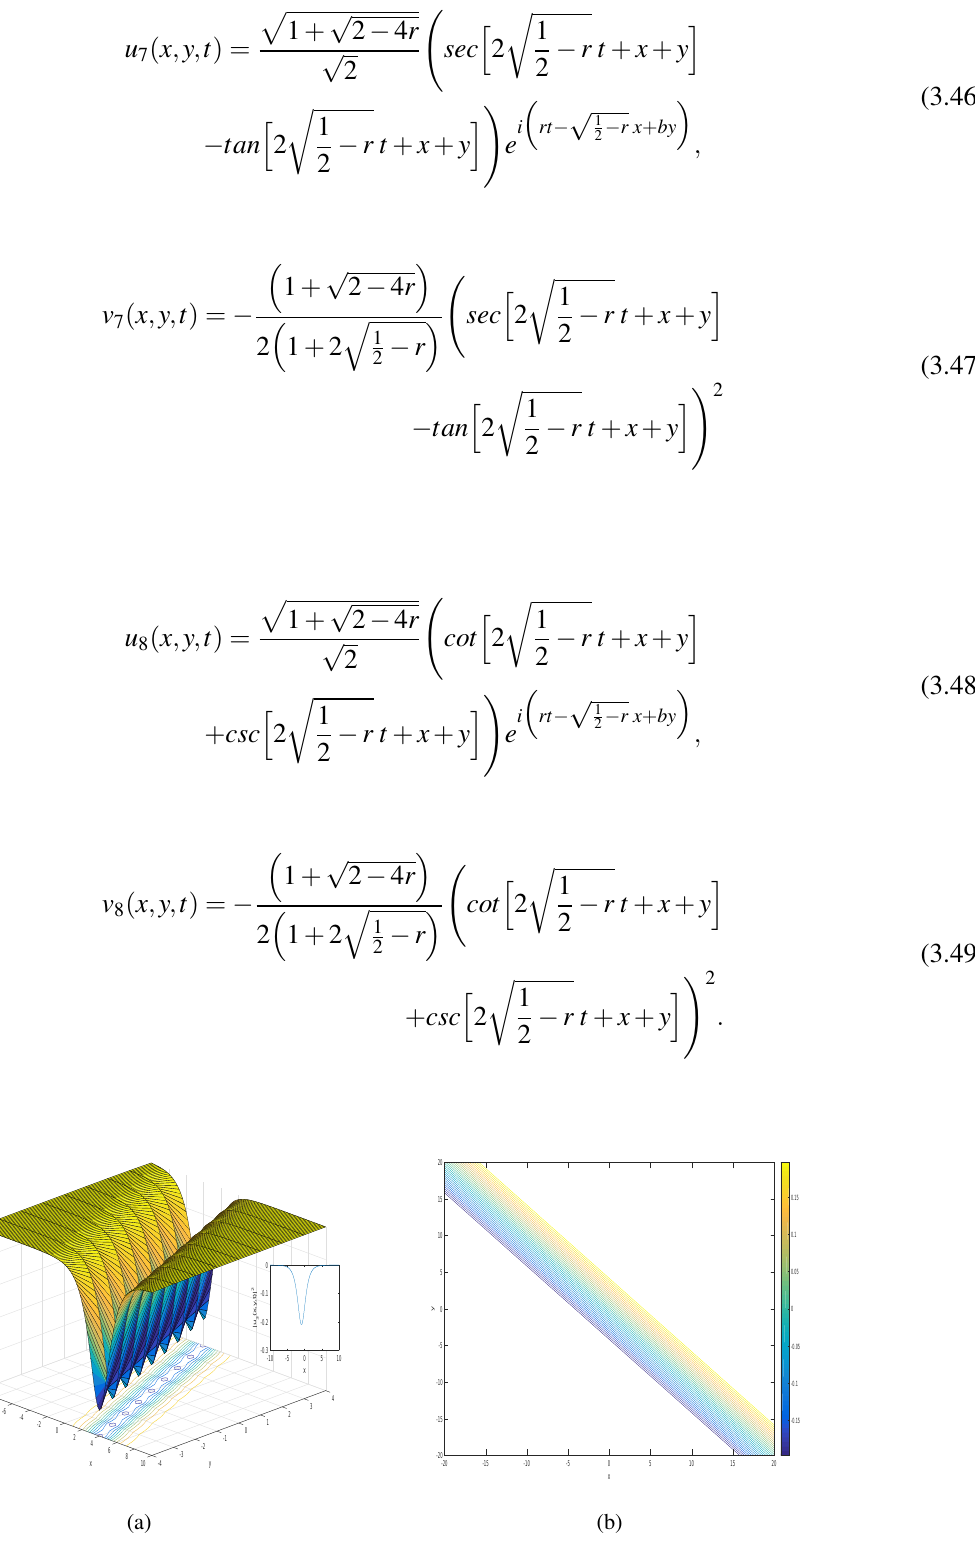
Figure 1 The (a) 3D, 2D surfaces (b) contour plot of Eq.